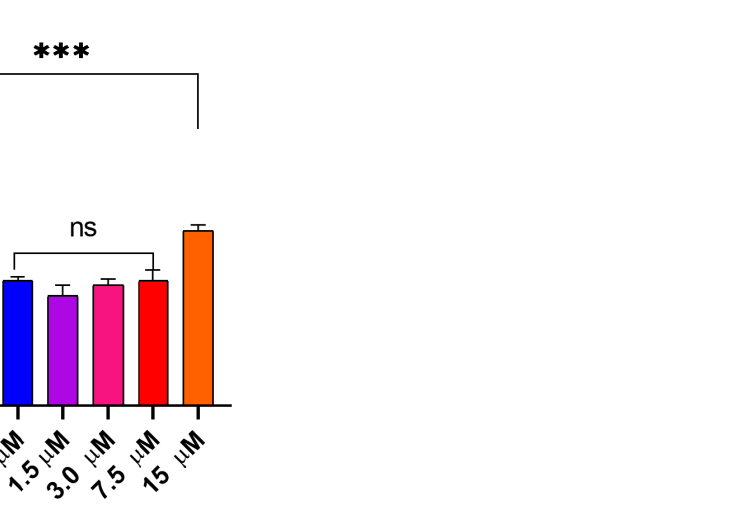
Figure 5. The viability of P. aeruginosa planktonic culture following treatment with different concen- trations of GaPP-LCNP (0.4 to15 µ M), light dose of 17.2 J.cm − 2 compared to negative control treated with saline in the dark. Data presented as mean ± SD, n = 3. ns: non-significant, *** significant reduction in viability, p value < 0.0001, ** p value = 0.003 (one-way ANOVA test followed by multiple comparison Tukey’s test).